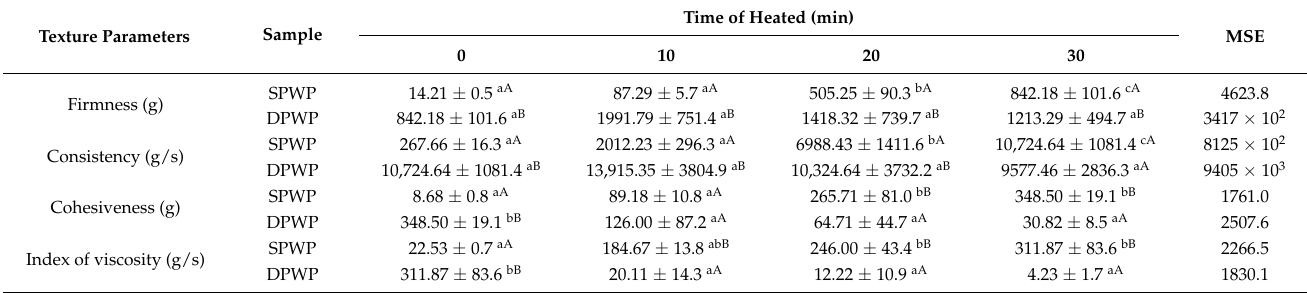
Table 3. Texture parameters polymerized whey protein depending on the heating time.